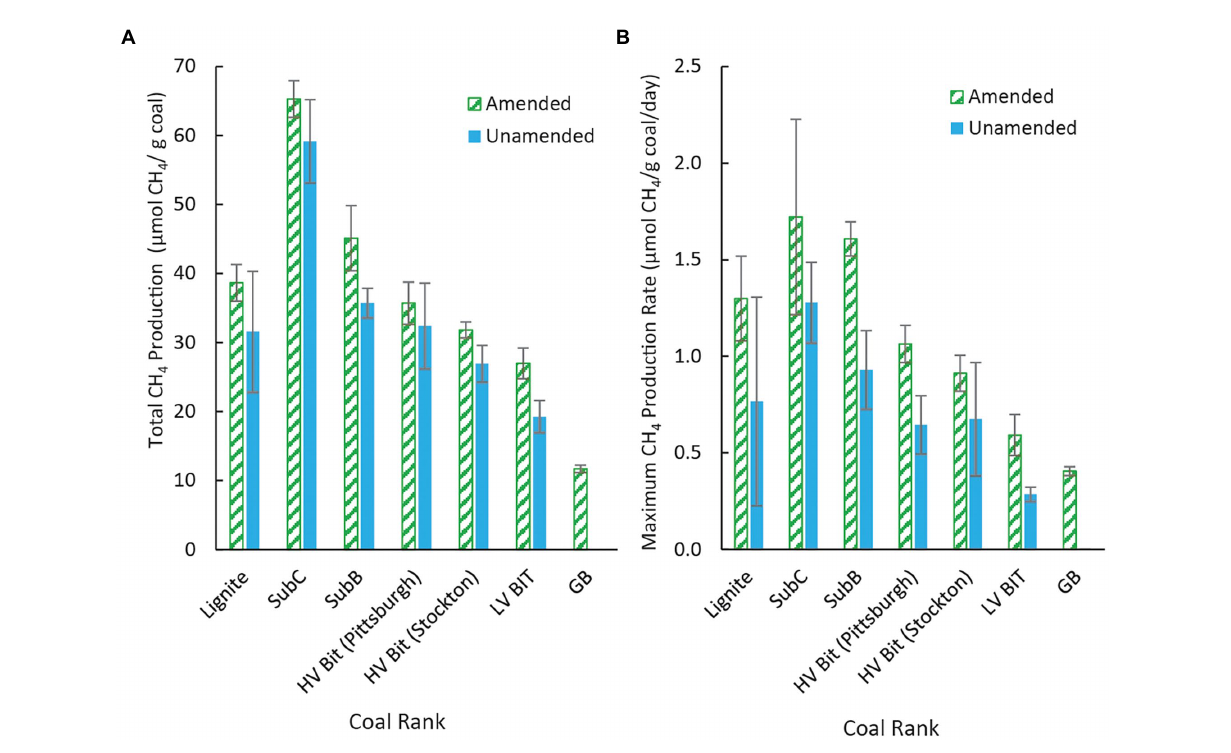
FIGURE 2 (A) Methane production in unamended microcosms and amended microcosms for coals of different rank and (B) Maximum methane production rate by coal rank for both amended and unamended microcosms. Maximum methane production rates occurred during different time intervals (see text), depending on the enrichment. Error bars represent one standard deviation of measurements from triplicate